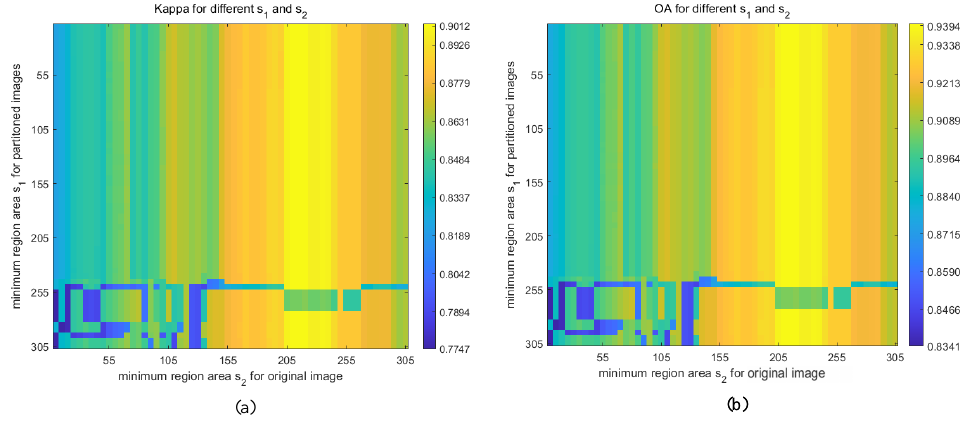
Figure 4. Kappa and OA for different s 1 , s 2 (minimum region area) from 10 to 305 with step 5: ( a ) Kappa for different s 1 , s 2 ; ( b ) OA for different s 1 , s 2